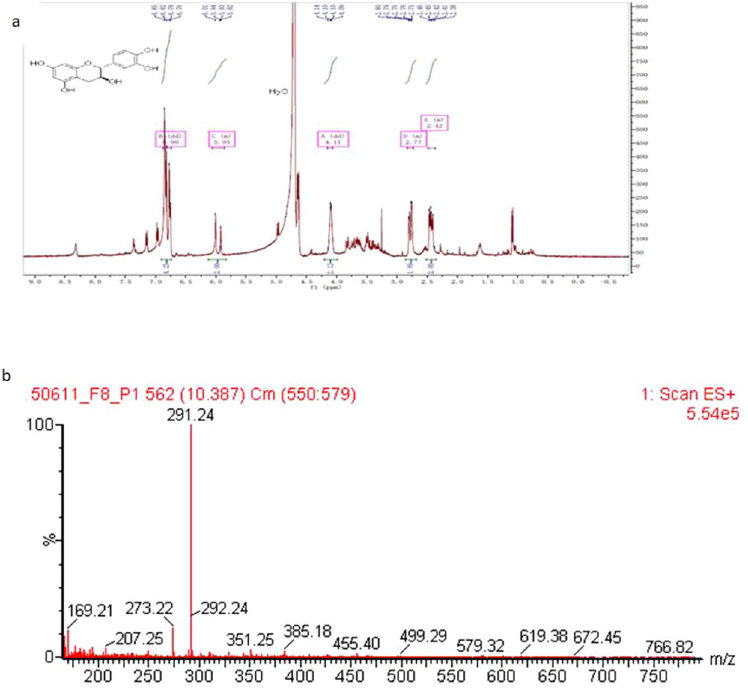
Figure 8. NMR ( a ) and HRMS analysis ( b ) of